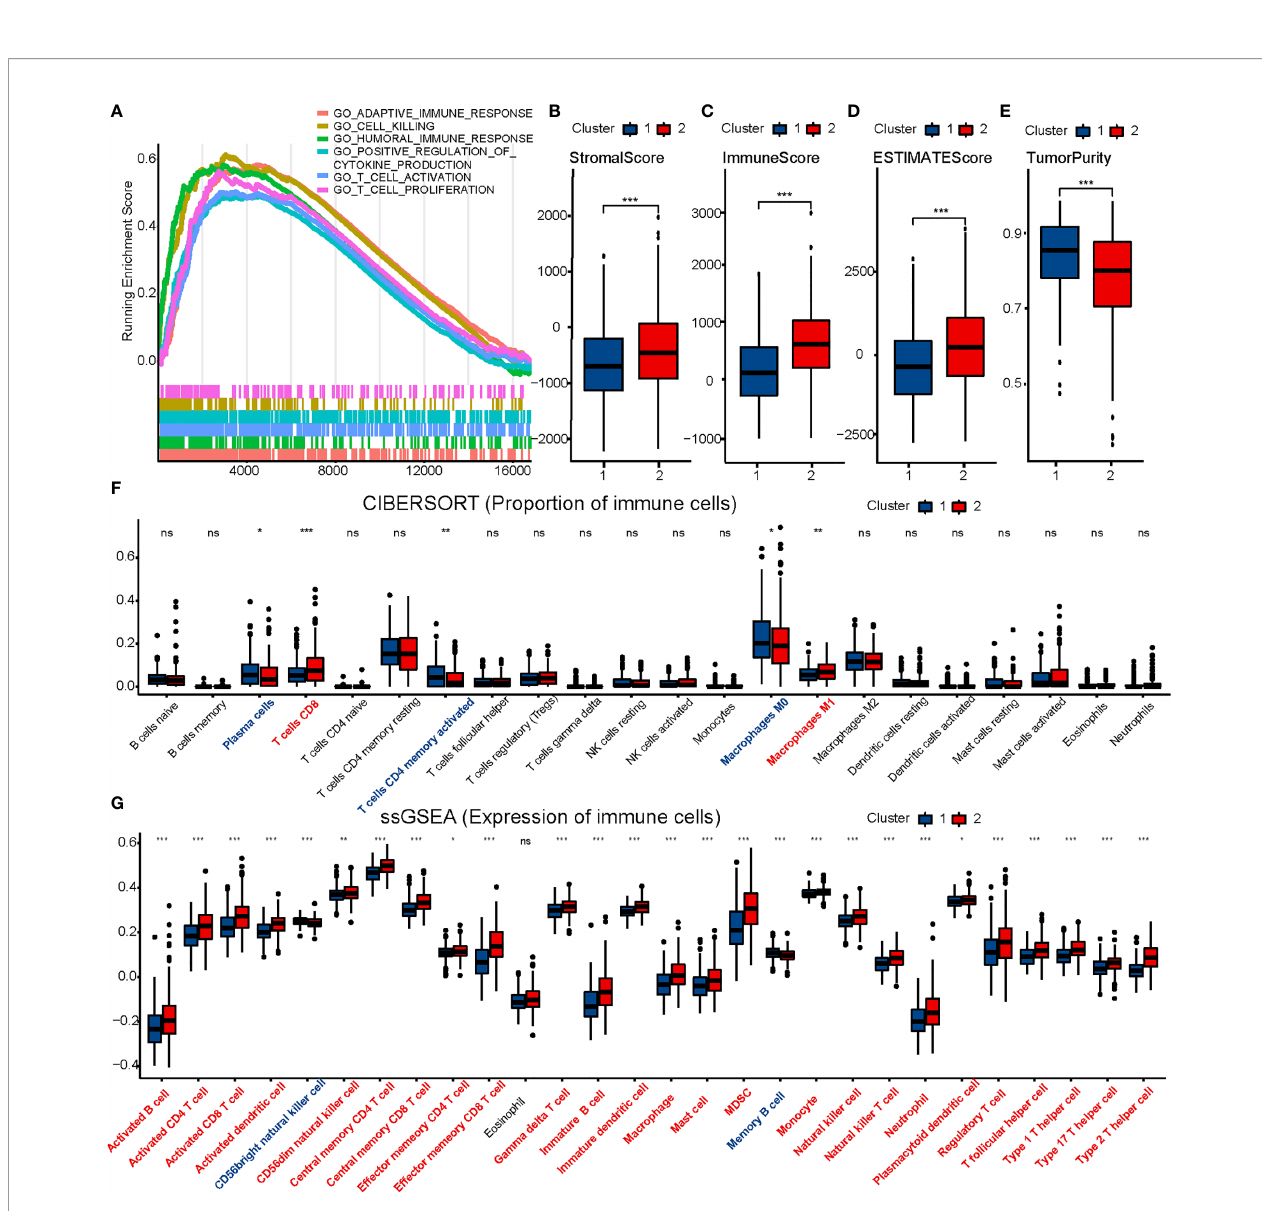
FIGURE 2 | Comparison of immune characteristics between two clusters. Comparison of functional enrichment (A) , stromal score (B) , immune score (C) , ESTIMATE score (D) , tumor purity (E) , proportion of immune cells (F) and expression of immune cells (G) between two clusters. The P values are labeled using asterisks (ns, no signi fi cance, *P < 0.05, **P < 0.01, ***P <